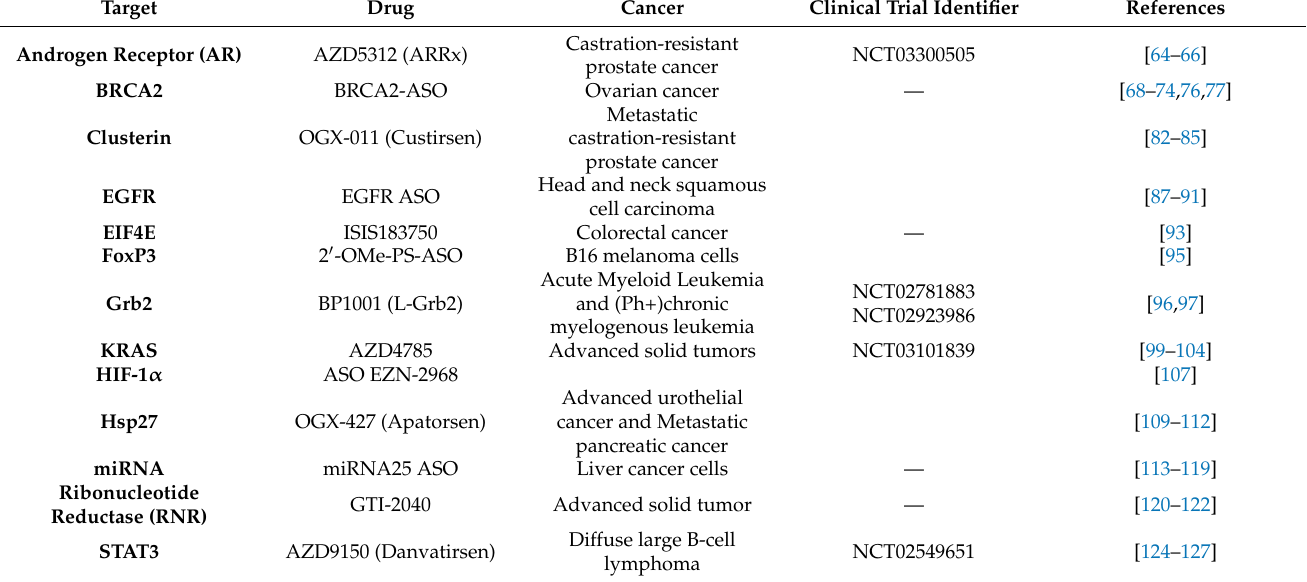
Table 3. List containing the gene targets, their proposed transcriptional drugs, and the tumor where the drug potentially acts; the associated Clinical Trial Identifier code is reported if assigned. Target Drug Cancer Clinical Trial